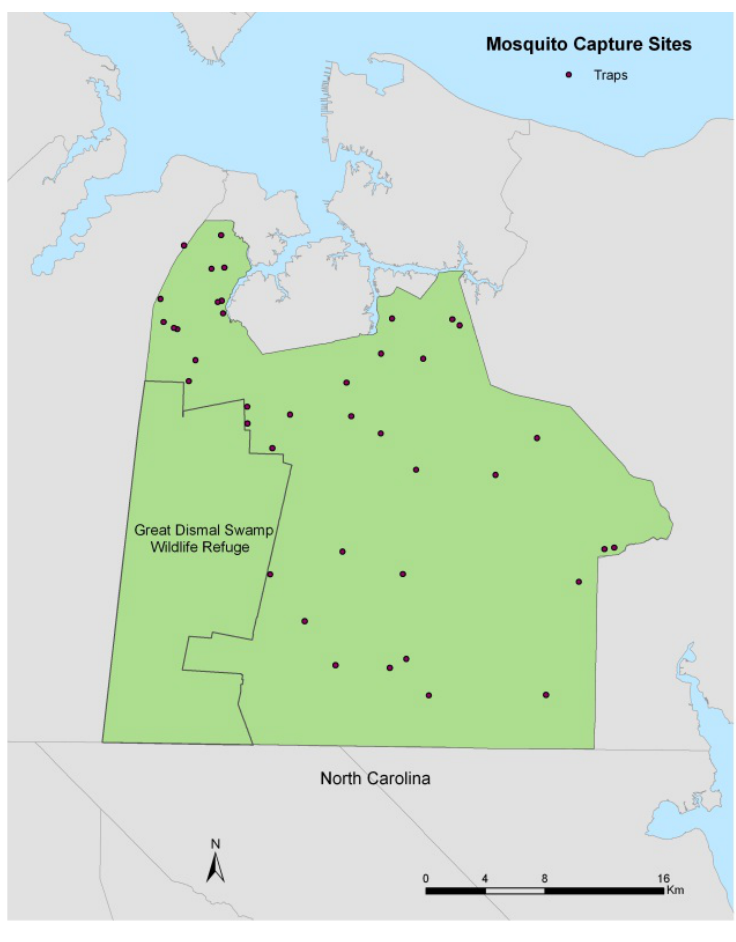
Figure 2. Mosquito light trap locations throughout City of Chesapeake in